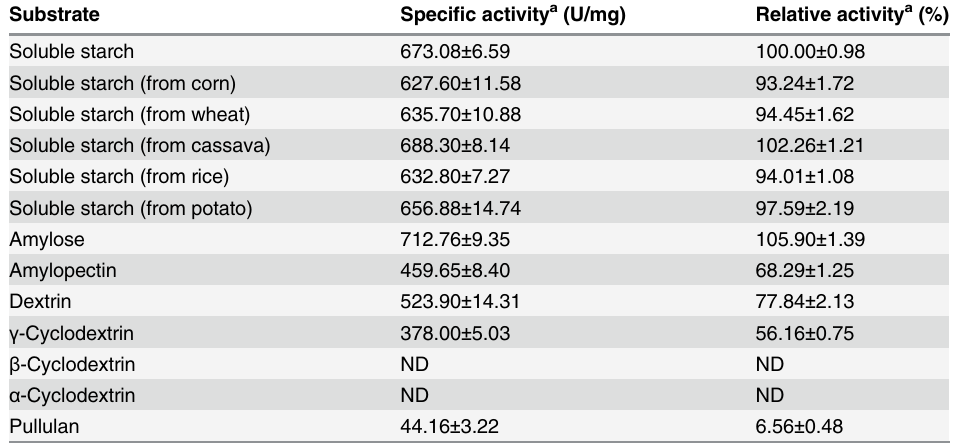
Table 5. Substrate specificity of TpAA.